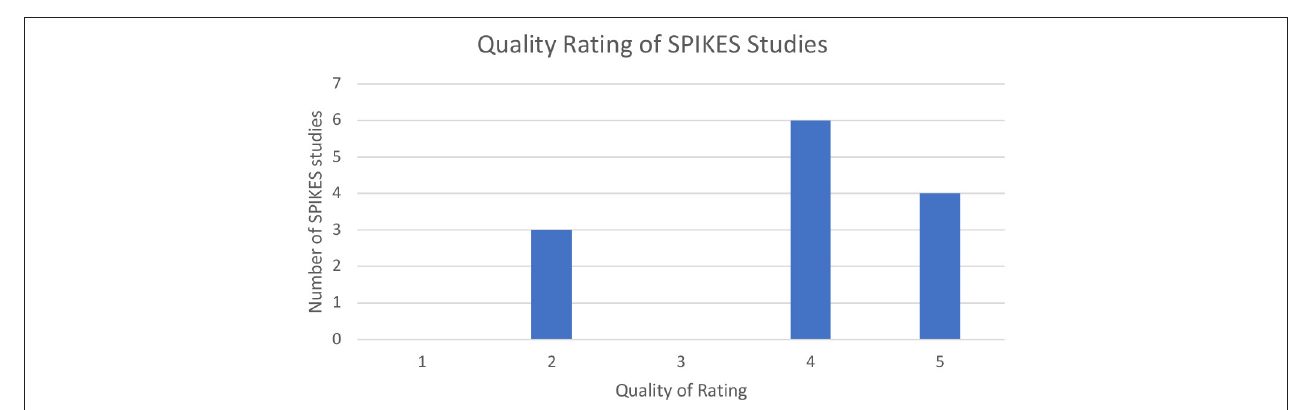
FIGURE 3 | Quality rating of SPIKES